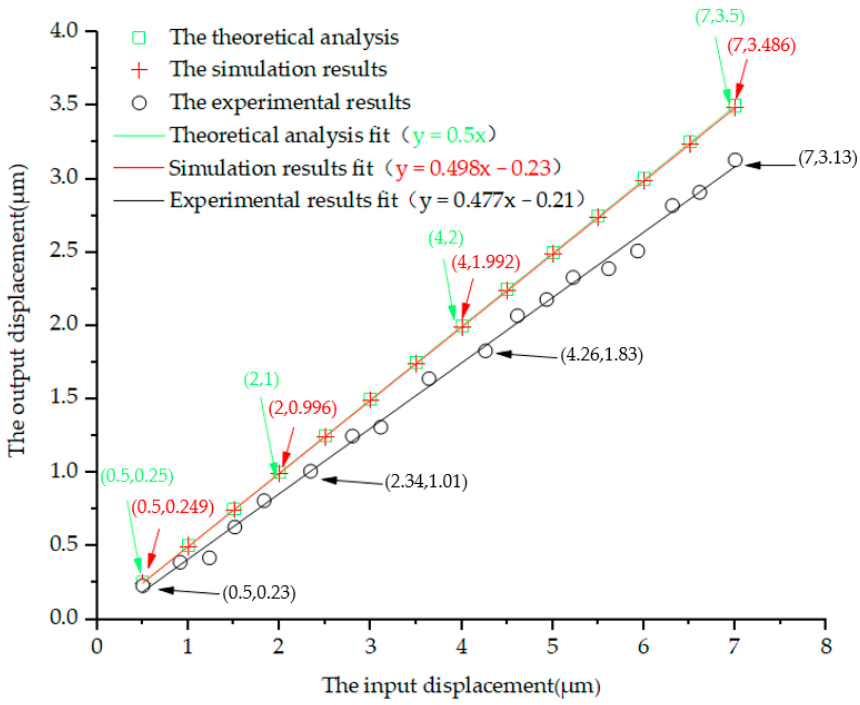
Figure 17. Results of the analysis of motion performance of the miniaturized system.